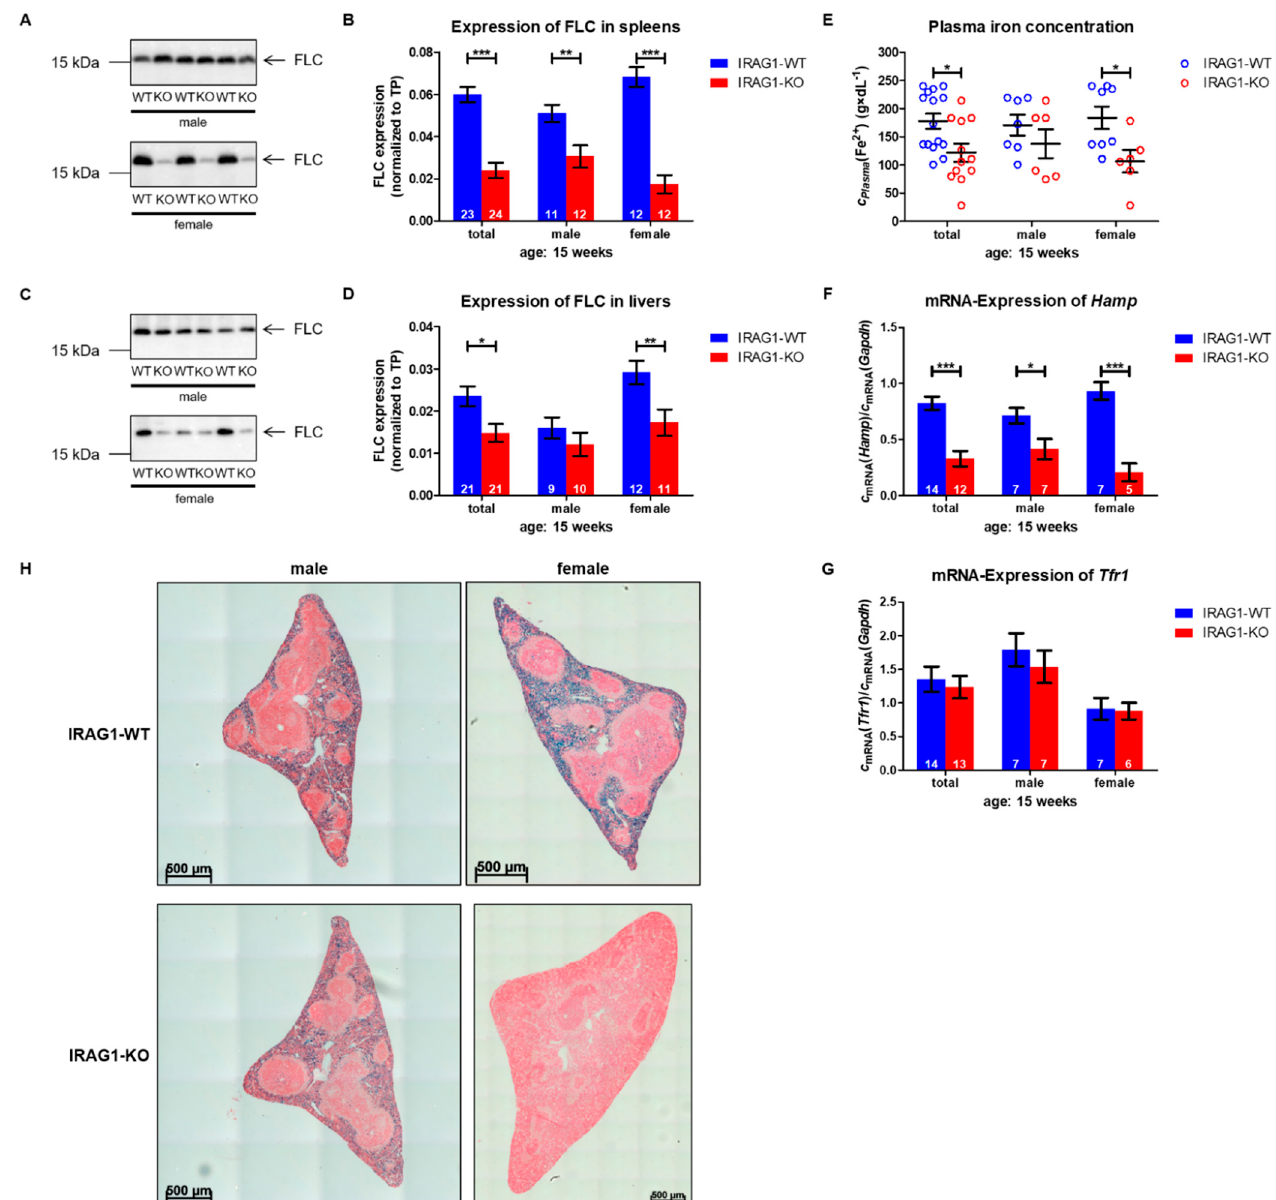
Figure 4. Iron deficiency in IRAG1-KO mice. ( A , B ) Representative ferritin light chain (FLC) expression ( A ) and statistical analysis of FLC expression ( B ) in the spleen of male and female IRAG1-WT (WT) and IRAG1-KO (KO) mice. ( C , D ) Representative FLC expression ( C ) and statistical analysis of FLC expression ( D ) in the liver of male and female IRAG1-WT and IRAG1-KO mice. ( E ) Reduced plasma iron (Fe 2+ ) concentration in total and female IRAG1-KO mice (total: n = 12; female: n = 6) in relation to IRAG1-WT mice (total: n = 15; female: n = 8). Male IRAG1-KO ( n = 6) exhibited no significantly lower plasma Fe 2+ concentration compared to IRAG1-WT mice ( n = 7). ( F ) Hepcidin-mRNA ( Hamp ) was significantly reduced in IRAG1-KO mice compared to the WT littermates. ( G ) mRNA expression of the transferrin receptor 1 ( Tfr1 ) was not altered between IRAG1-WT mice and IRAG1-KO mice. ( H ) Iron staining (blue color) in spleens of representative sections of male and female IRAG1-KO and IRAG1-WT mice. Blue staining was detectable in male and female IRAG1-WT mice. Female IRAG1-KO mice had a strong reduction in detectable iron in the spleen, in contrast to male IRAG1-KO mice, which had only a slight reduction in the iron-staining compared to their WT littermates. The numbers in the graphs ( B , D , F , G ) indicate the mice that were investigated; the mean ± SEM is shown. The circles ( E ) indicate the individual value of each mouse, and the mean ± SEM is shown by bars. Significant differences are shown by (*) ( p < 0.05), (**) ( p < 0.01) and (***) ( p < 0.001). Images of total protein (TP) were shown in Figure S5.